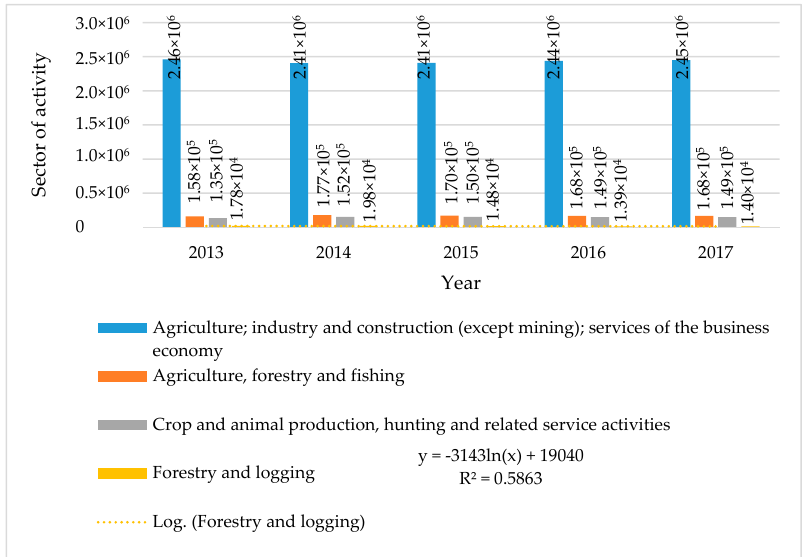
Figure 4. The distribution of non-fatal work accidents on the main fields of activity for the EU member states during 2013–2017 [1,7].